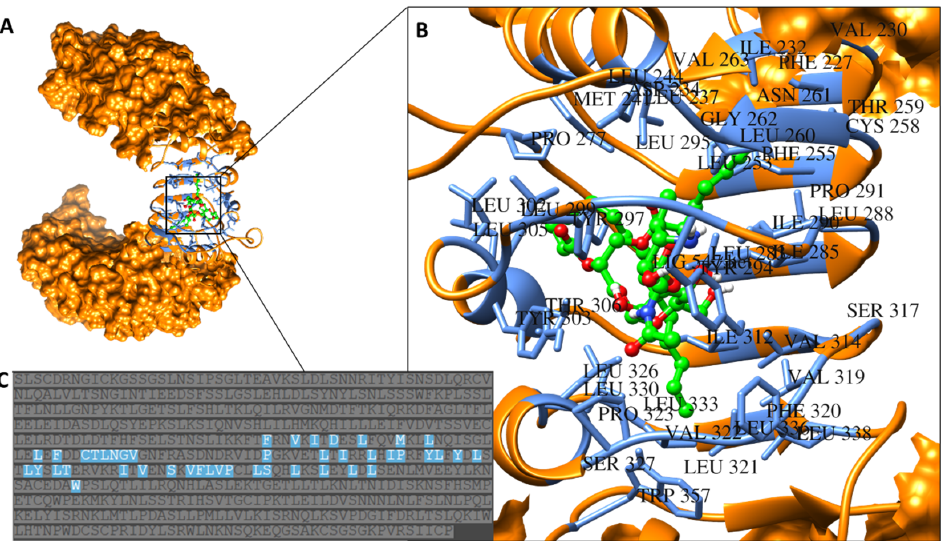
Figure 2. ( A ) Location of LTA (green) binding on TLR2. ( B ) Specific binding site amino acid resi- dues on TLR2 (blue) bound by LTA (green). ( C ) Sequence of TLR2 with specific binding site residues highlighted in blue correlating with residues identified in ( B ).